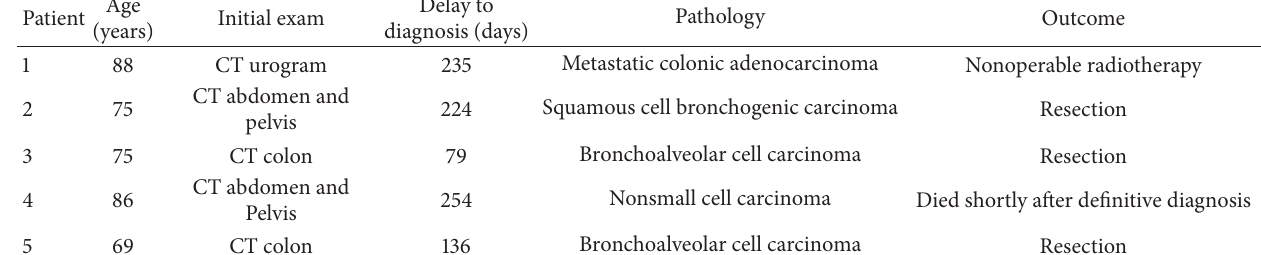
Table 1: Summary of 5 lung cancers missed on the scout views of abdominopelvic CT scans.